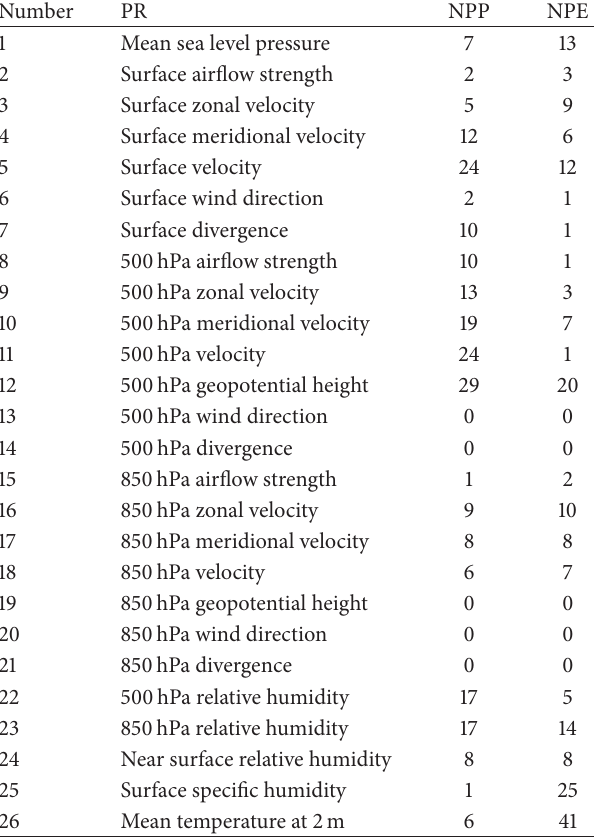
Table 5: Determination of coefficients ( 𝑅 2 ) and Nash-Suttcliffe ) for prediction of rainfall at the selected 41 sites in coefficients ( 𝐸 ns the validation period